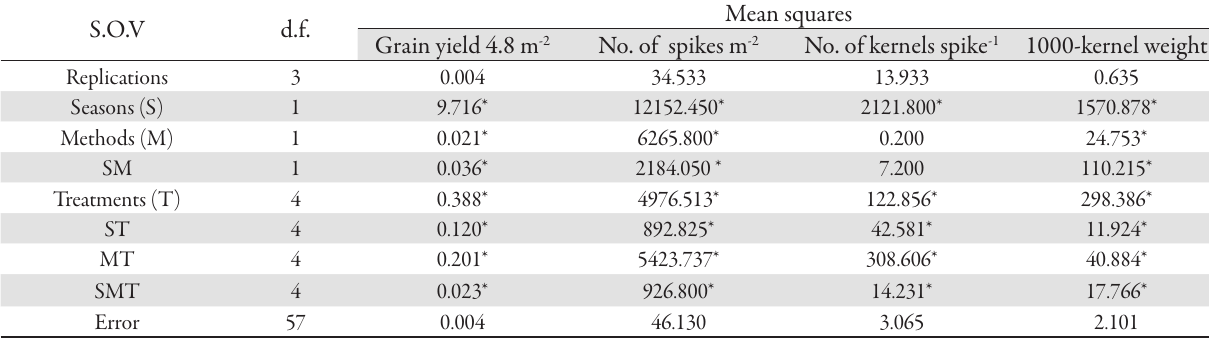
Tab. 5. Mean square analysis of four characters for ‘Sakha 93’ bread wheat cultivar using bio-control agents by soil and grain methods in 2009/2010 and 2010/2011 seasons